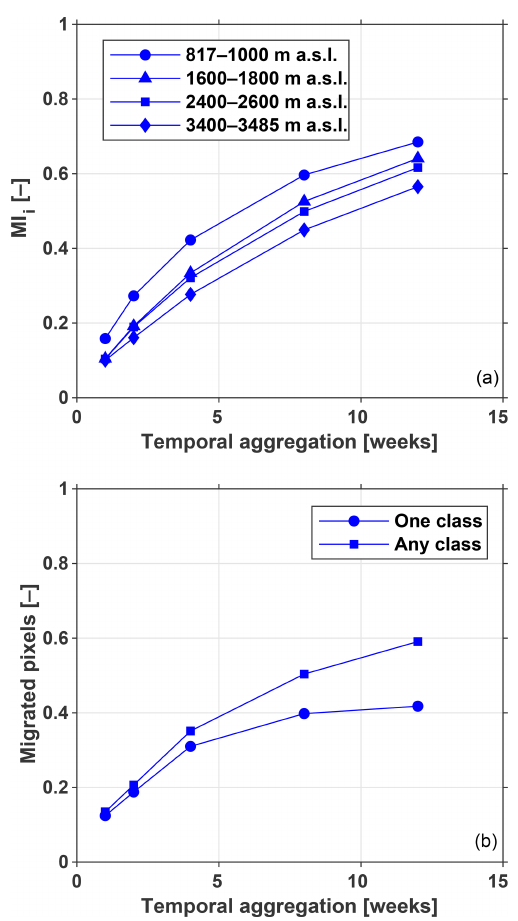
Figure 3. (a) Band migration index for the five temporal aggrega- tions, reported for four elevation bands (lowest elevation band of 817 to 1000m; 1600 to 1800m; 2400 to 2600m; and the high- est elevation band of 3400 to 3485m). (b) Fraction of migrated pixels computed for the five temporal aggregations over all eleva- tion bands. Circles refers to pixels that migrated ± 1 energy class, squares to total migrated